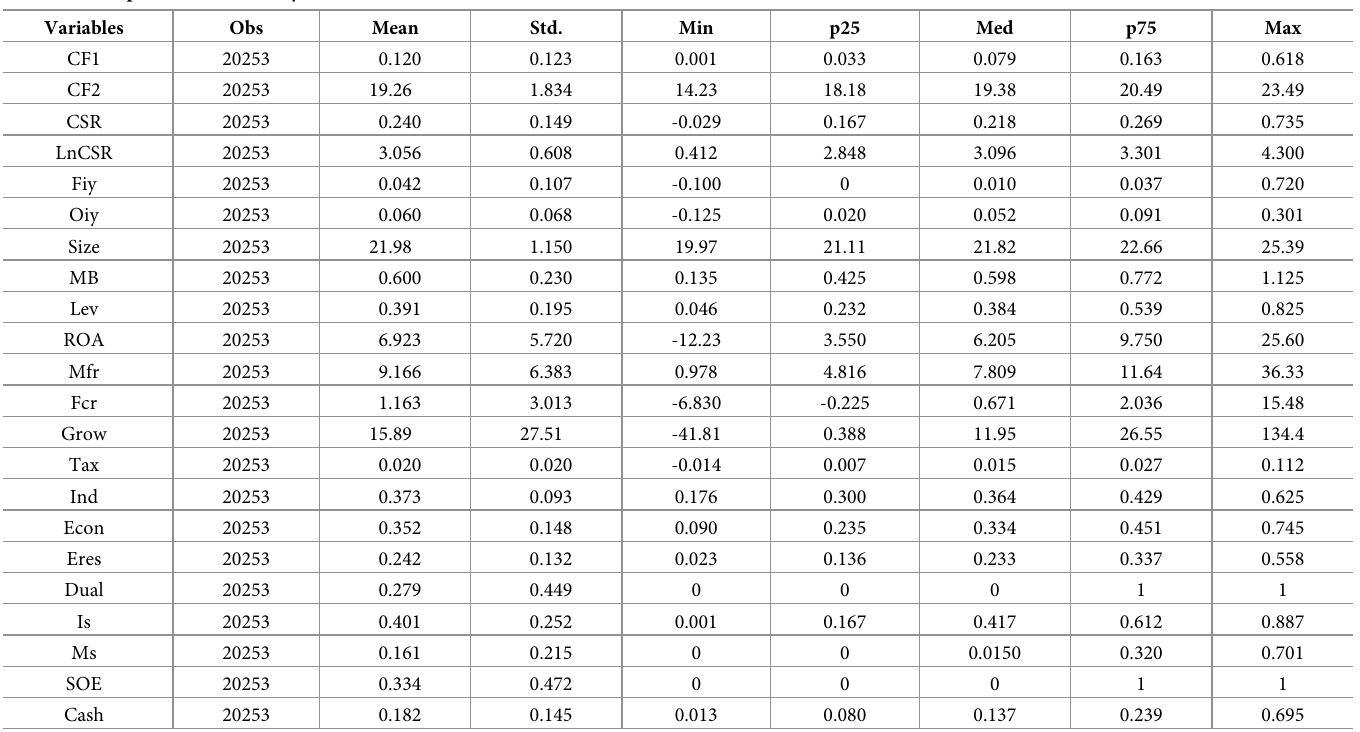
Table 2. Descriptive statistical